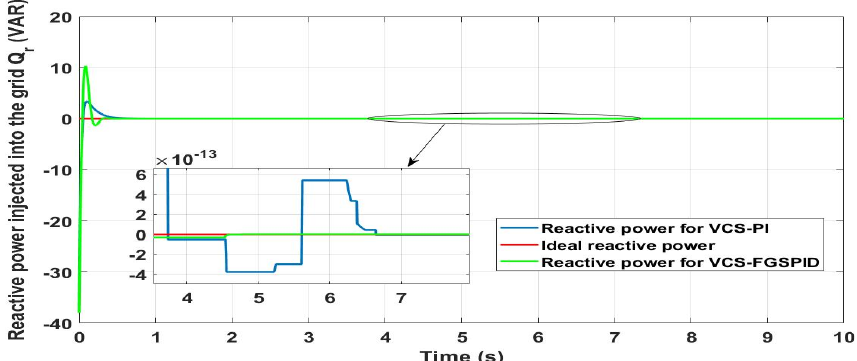
Figure 27. Reactive power injected into grid.